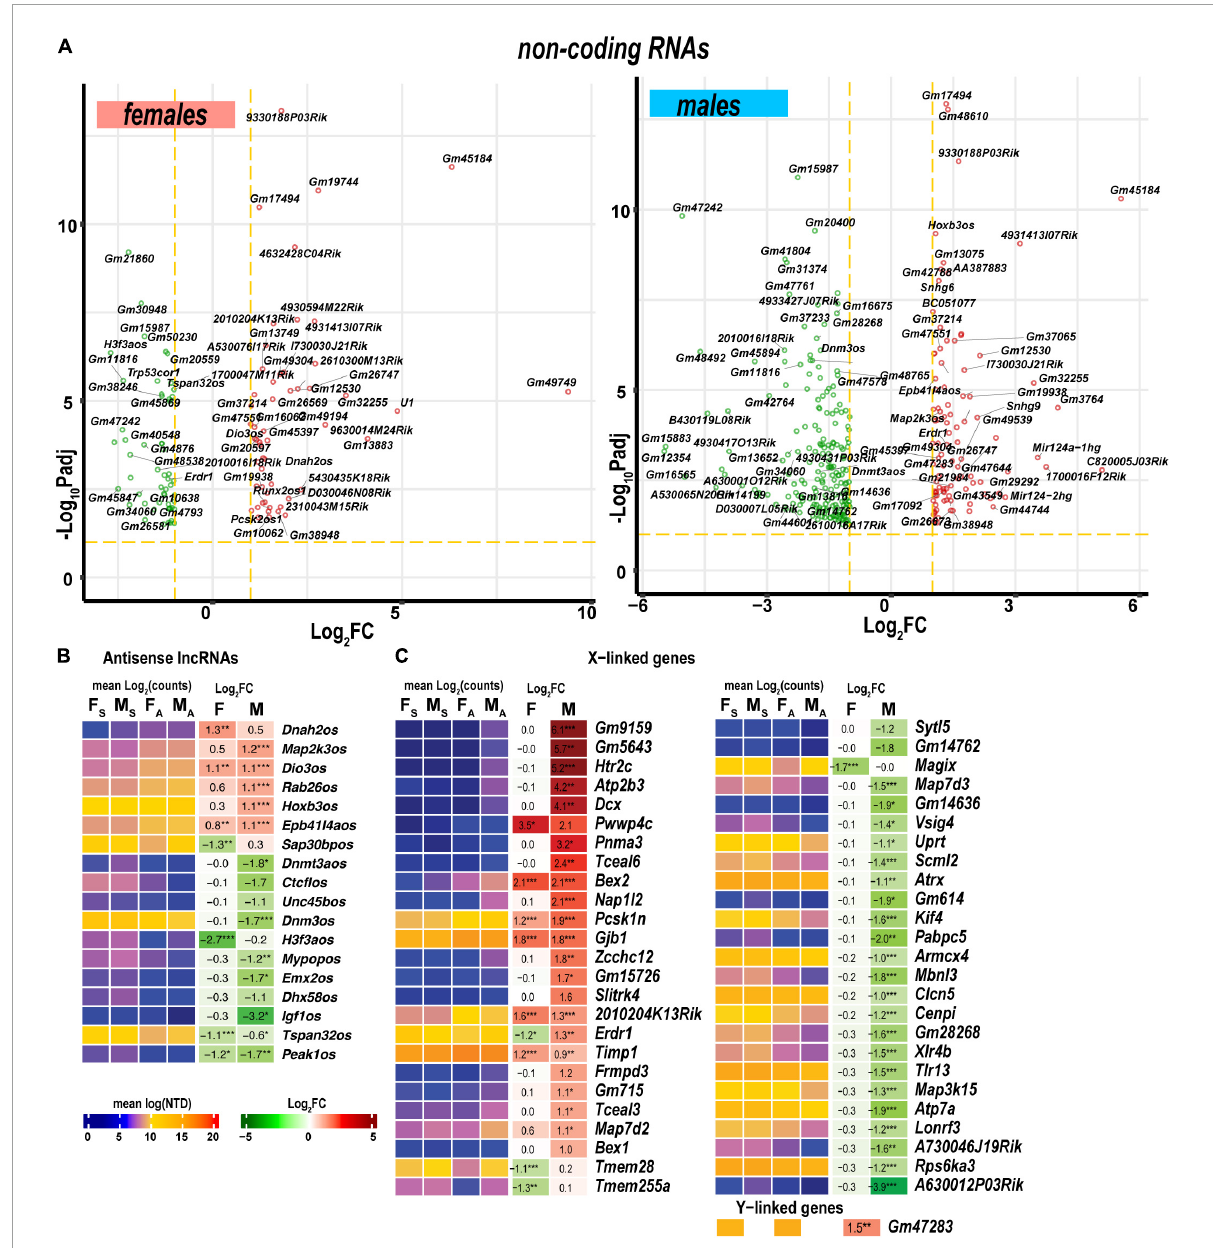
FIGURE9 Regulated ncRNA and sex chromosome-linked differentially expressed genes (DEGs) exhibited profound sexual dimorphism. (A) Significant ncRNA DEGs in female (left panel) and male (right panel) mice. Volcano scatter plots show –log 10 P adj and log 2 FC. Red and green colors indicate up-and downregulated ncRNAs, respectively. Thresholds (log 2 FC > 1 or log 2 FC < –1) and –log 10 P adj < 0.1 are shown by yellow dotted lines. Selected DEGs are labeled by gene symbols. (B) Regulated antisense lncRNA DEGs. (C) Regulated sex chromosome-linked DEGs. Heatmaps display normalized mean log 2 (counts) in sample groups (F S , female sham; M S , male sham; F A , female axotomy; M A , male axotomy) and log 2 FC in female (F) and male (M); ( n = 6 mice/group, 2 mice/sample (pooled), 3 sample/group) of respective DEGs. Heatmap colors correspond to the respective scales. Log 2 FC significance was determined in DESeq2 using Wald test: *, p ≤ 0.05; **, p ≤ 0.005; ***, p ≤ 0.0005. DEGs were sorted by log 2 FC.